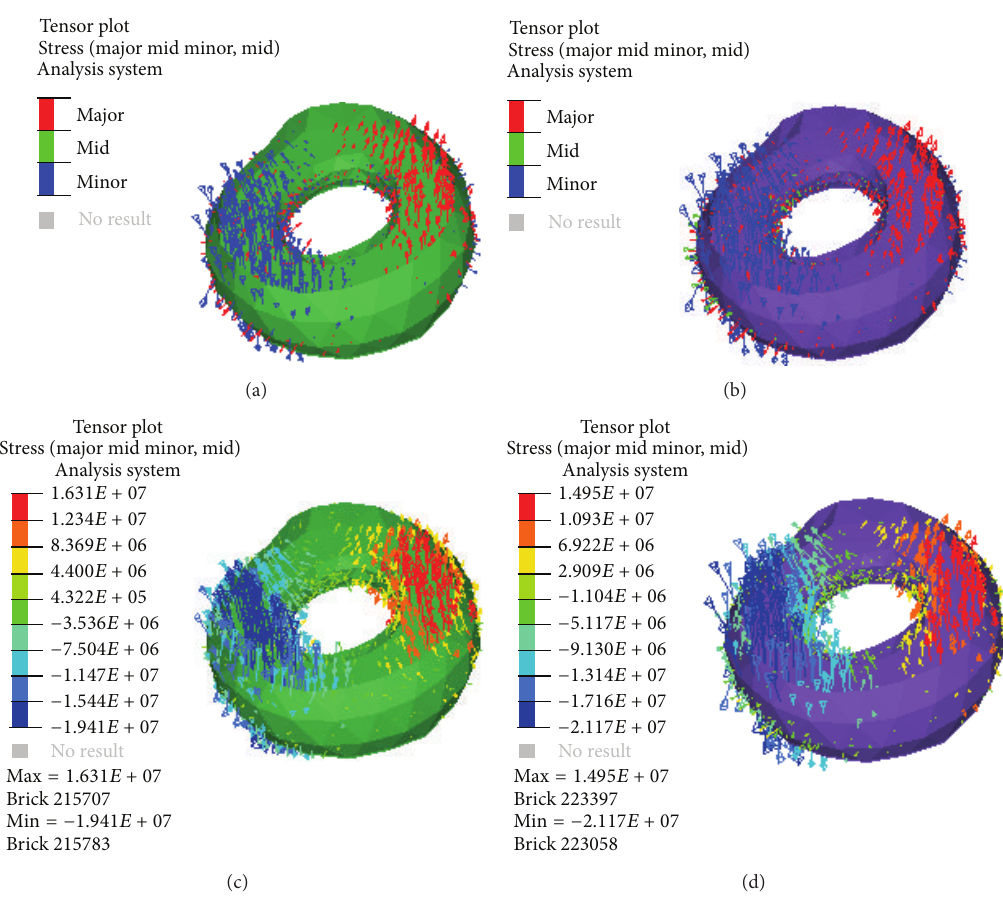
Figure 4: Tensor plot of the principal stresses of the two models’ callus in the two different healing stages (a, b) with direction; the red colour represents compressive stress and the blue colour represents tensile stress; (c, d) with value. (a) PFNA-II model in SCS; (b) A2FN model in